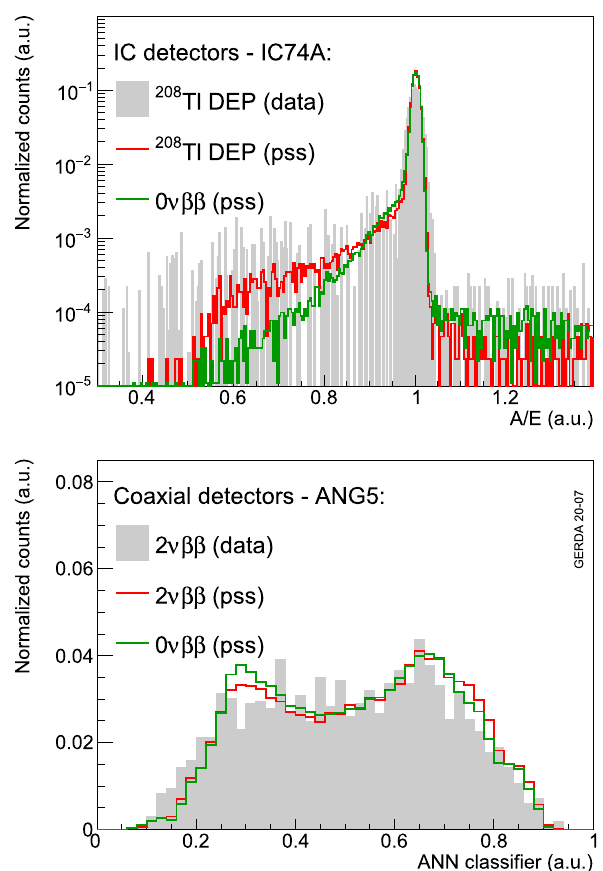
Fig. 22 Signal proxy and 0 νββ decay events PSD classifier distribu- tions for an inverted coaxial (top) and a coaxial (bottom) detector. The pulse shape simulation results (colored lines) are superimposed on the data (grey area). The histograms are normalized to their